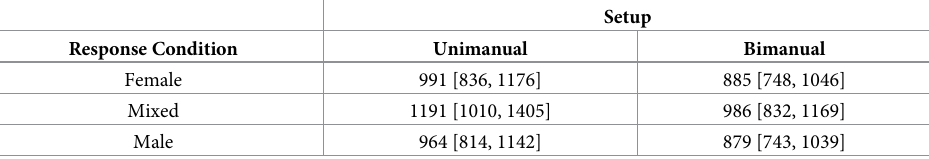
Table 2. Estimated means [and 95% confidence intervals] for response time (ms) as a function of setup and response condition (complex